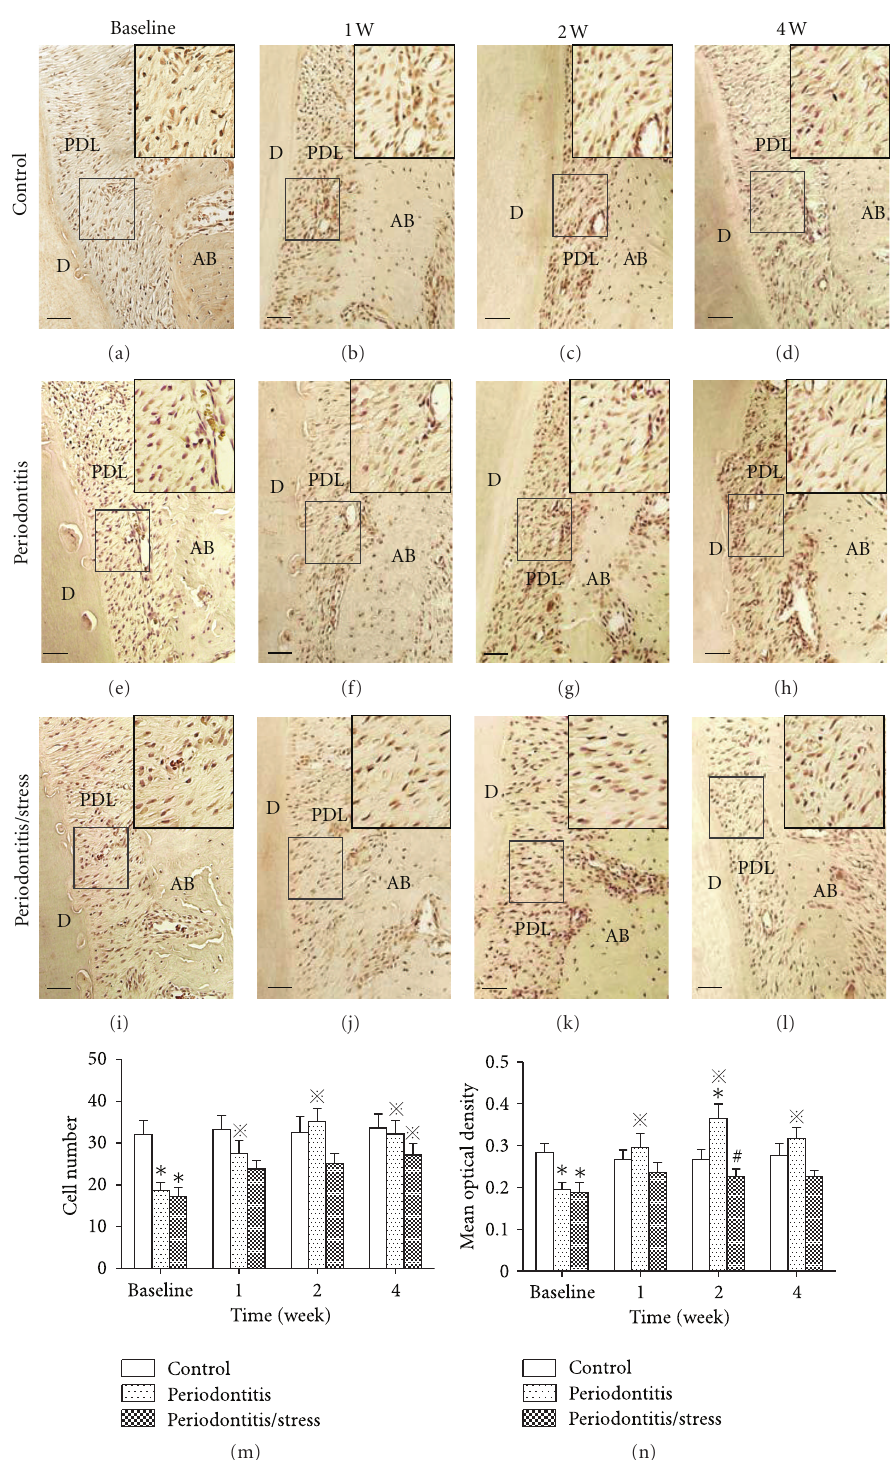
Figure 8: Immunostaining of basic fibroblast growth factor. ((a)–(l)) Area comprising the mesial root surface of the maxillary second molar of all groups at all time points (D: dentin, AB: alveolar bone, and PDL: periodontal ligament, 200, bar represents 100 μ m). The boxed areas (cid:0) indicate a higher magnification ( 400). ((m)-(n)) Quantitative analysis of the number of immunoreactive cells (m) and the intensity of (cid:0) staining (n). (cid:0) P 0 . 05 versus control group at the same time point. # P 0 . 05 versus periodontitis group at the same time point. (cid:2)(cid:0) P 0 . 05 (cid:0) (cid:0) (cid:0) versus the same group at